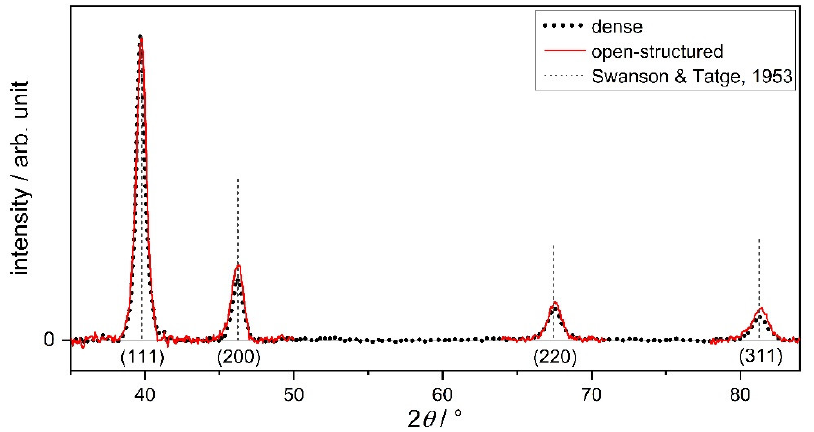
Figure 2. X-ray diffraction patterns (using Cu K α radiation) of the 60 nm thick dense and open-structured Pt thin films deposited on carbon paper (normalized to Pt{111}). Reference positions and intensities of the X-ray reflections from Pt powder based on Swanson and Tatge